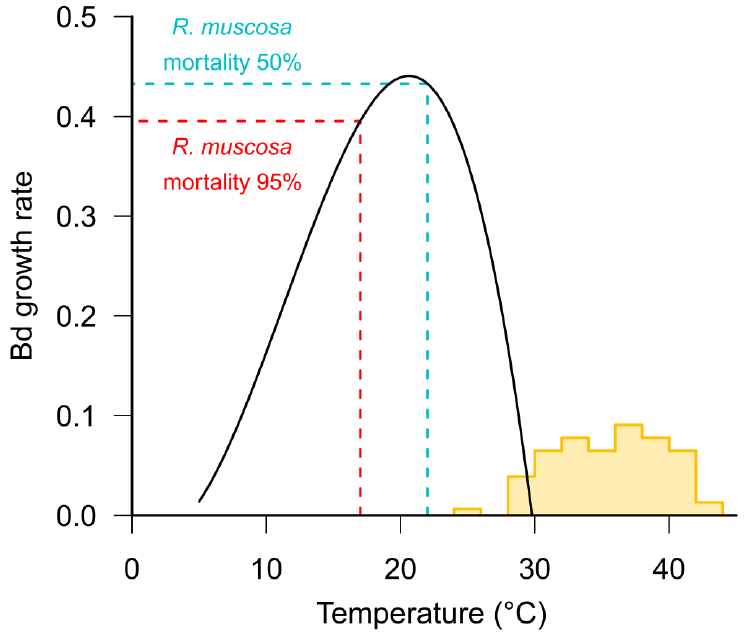
Figure 2. Effects of temperature on Batrachochytrium dendrobatidis (Bd) growth rates and amphibian survival. The Bd growth rate (black line) from Piotrowski et al. [65], using a curve fitted by Rohr et al. [81], is shown together with a frequency distribution (yellow) of upper critical temperature limits for 77 anurans based on data in the supplementary materials of Sunday et al. [82]. Vertical lines show the temperatures at which Andre et al. [78] found 95% mortality (red) and 50% mortality (cyan) in Rana muscosa .